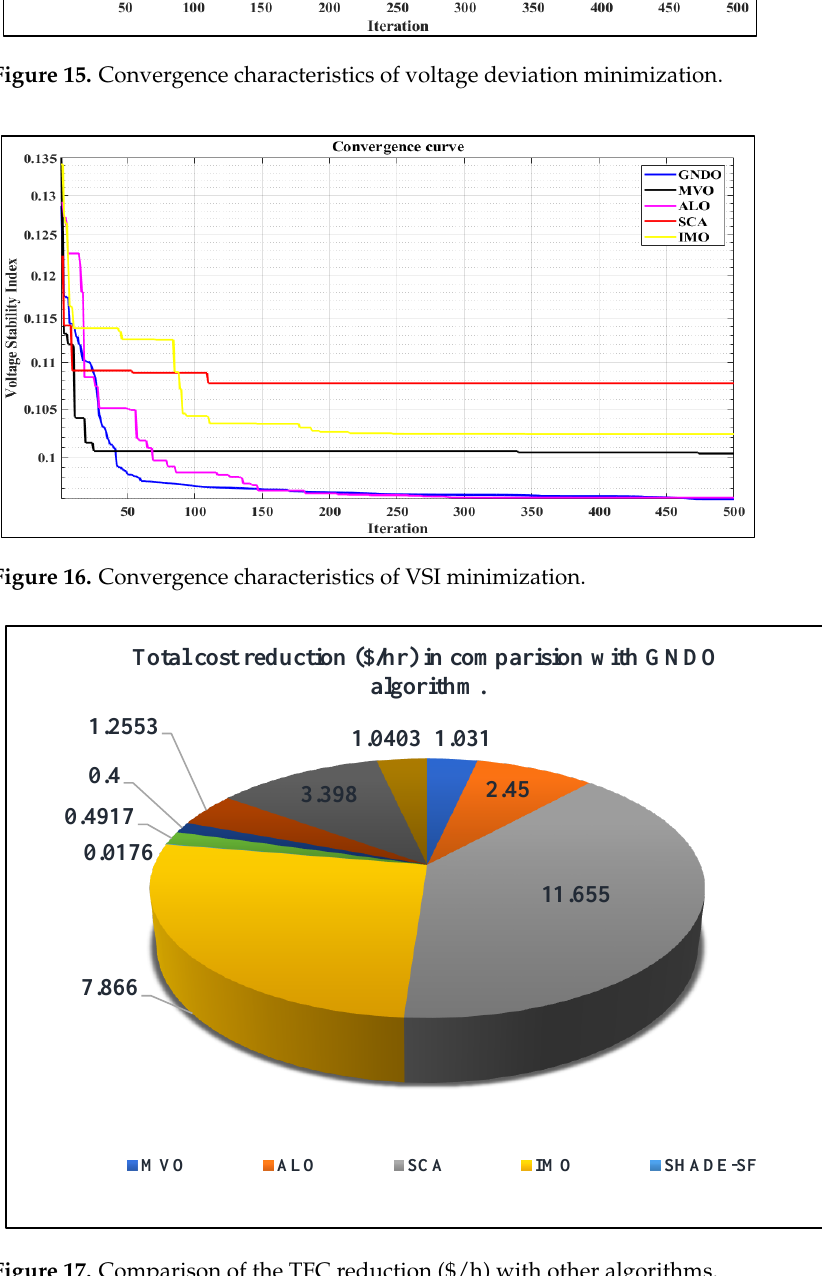
Figure 18. Comparison chart for TFC minimization with different algorithms.